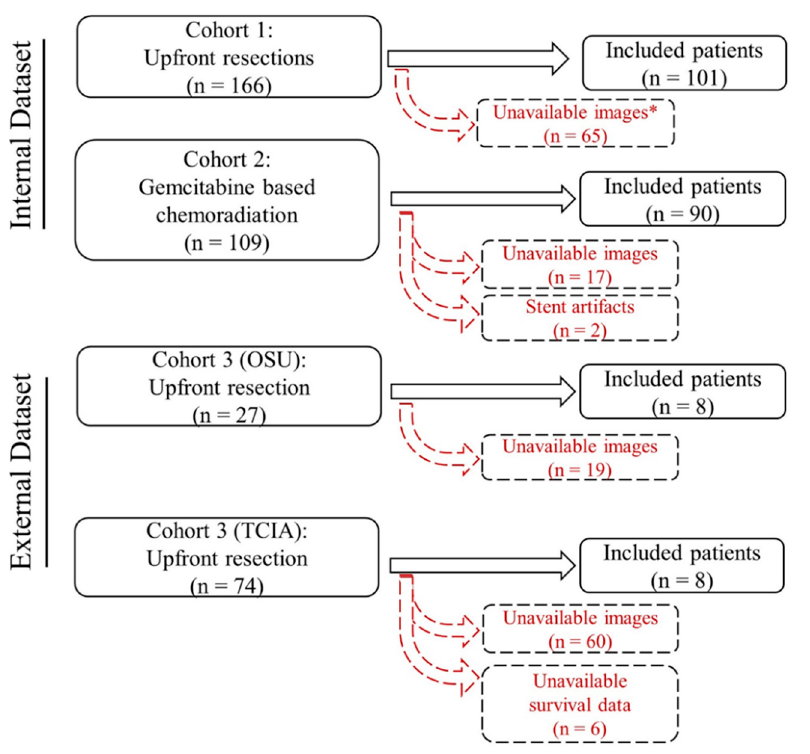
Figure 4. Flow diagram of the included patients in the three studied cohorts. * Unavailable images: pancreas protocol CT scans are either unavailable or missing one or more phases. Abbreviations: OSU: Ohio State University; TCIA: The Cancer Imaging Archive.